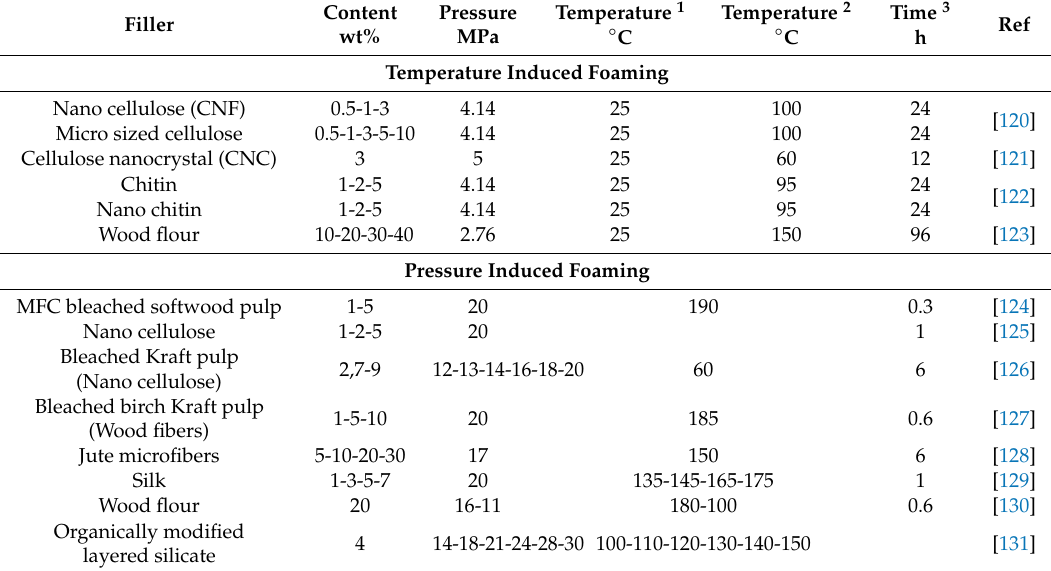
Table 1. Operating conditions used in the batch foaming process for polylactic acid (PLA)-based (nano)